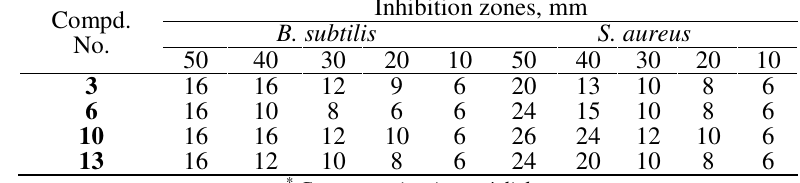
Table 3. MIC of the biological active compounds towards the gram positive bacteria * : Inhibition zones, mm B. subtilis